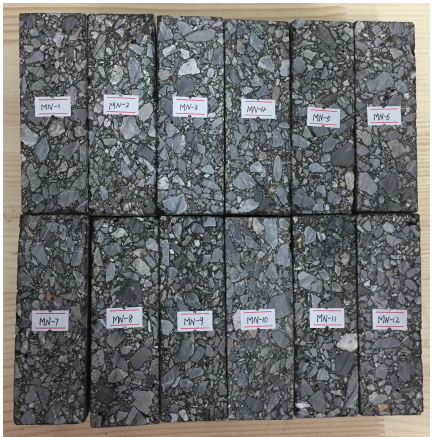
Figure 6. Dimensions of the cutting sample into the shape of a